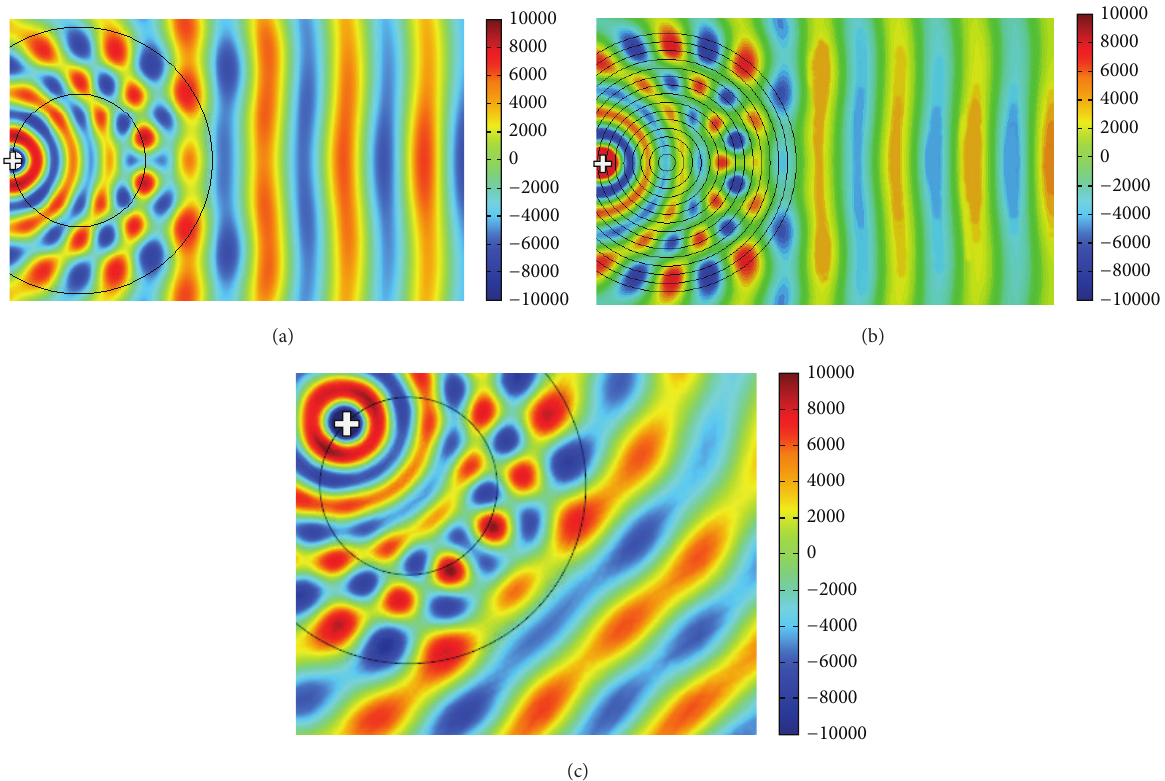
Figure 4: Simulated electric field distributions for a point source embedded within the modified Luneburg lens at 10GHz. (a) The lens has the ideal refraction index distributions as shown in (1). (b) The refractive index distributions of the lens are discretized. (c) Beam scanning for a point source moving along the circumferential direction.